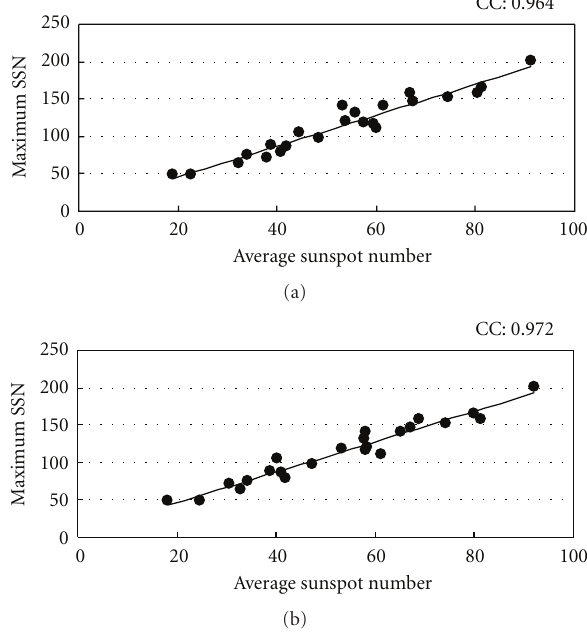
Figure 2: (a) Peak sunspot number versus average sunspot number when solar cycle is divided at the minimum. (b) is the same as (a); however the dividing point is set at three years before the minimum. CC on the top right-hand side of each map represents the correlation coe ffi cient.